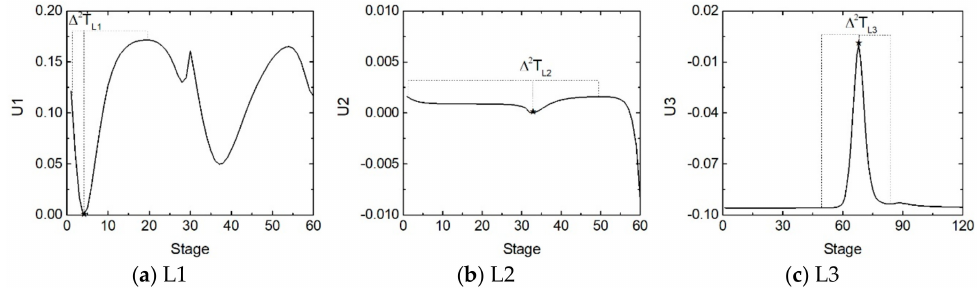
Figure 6. Singular value decomposition analysis profiles for simplified double temperature di ff erence control scheme (SDTDC): ( a ) L1; ( b ) L2; ( c )